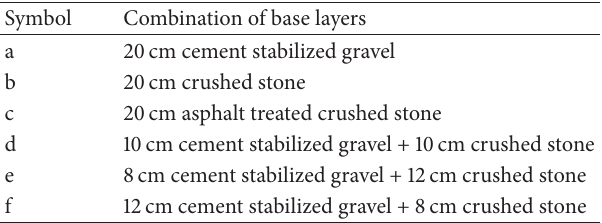
Table 2: Base combinations for multiple factor sensitivity analysis.